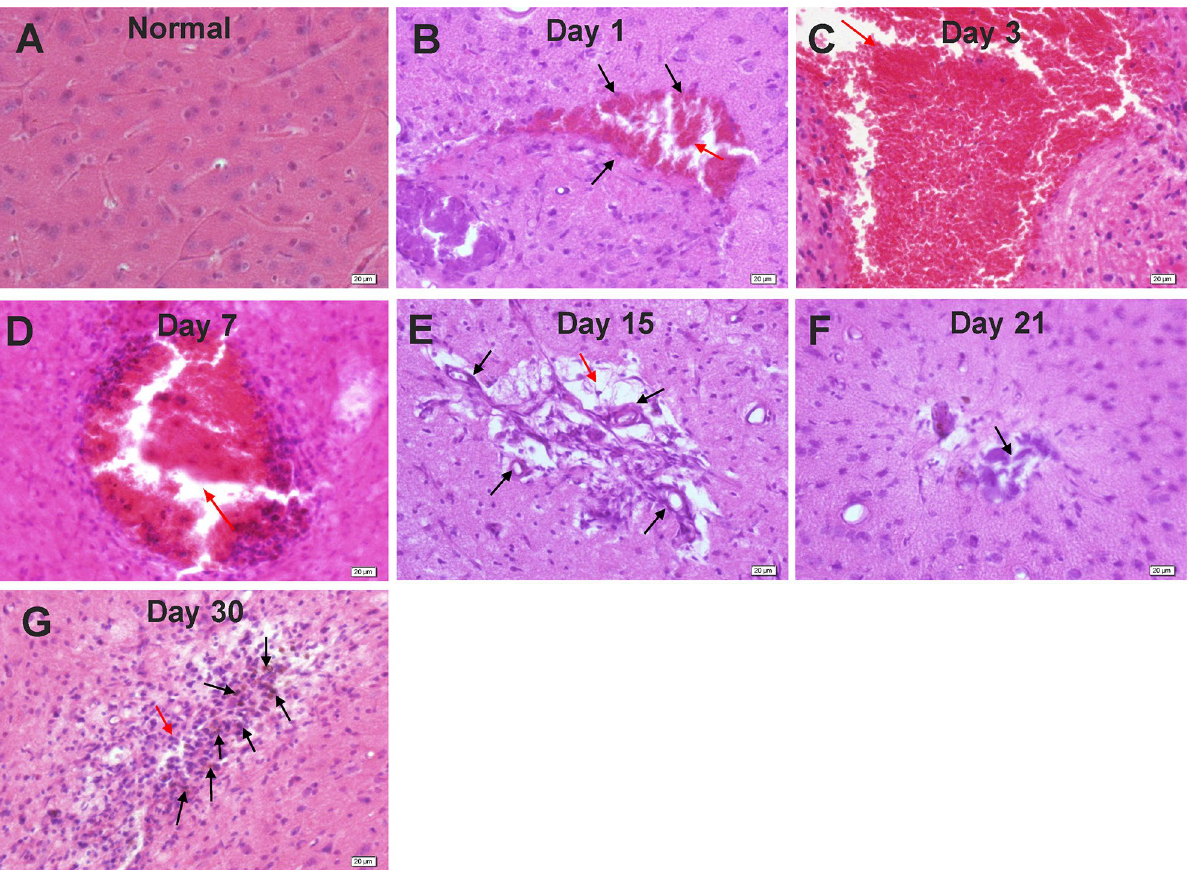
Figure 1. H&E-stained images of ( A ) normal mouse brain tissue and ( B – G ) mouse brain tissue on days 1, 3,7, 15, 21 and 30 days, following pTBI. ( A ) Regular size, shape, and arrangement of brain tissue cells were observed for normal mouse brain tissue. ( B ) On day 1 after inflicting pTBI in mouse models, damaged brain tissue and thrombosis (black arrows) were noted at the injury site (lesion indicated with a red arrow). ( C ) The degree of damaged tissue at the injury site (red arrow) was reduced on day 3. ( D ) On day 7 after pTBI, necrotic tissue and thrombus at the injury site (red arrow) were no longer visible. Instead, granulation was observed that was suggestive of new tissues (black arrows). The large lesion at the injury site (red arrow) was still observed. ( E ) The lesion at the injury site (red arrow) was still visible on day 15. ( F ) On day 21, the lesion (red arrow) appeared to have shrunken and hemosiderin particles (black arrows) were observed. ( G ) The lesion was no longer visible on day 30, but some hemosiderin particles remained (black